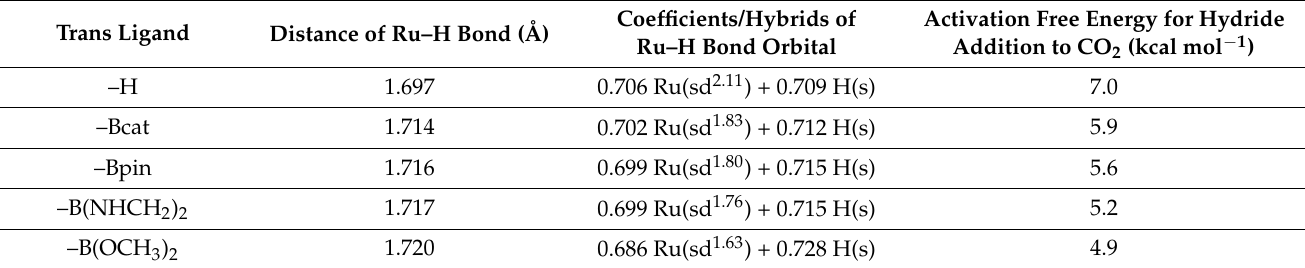
Figure 1. Free energy profile for the addition of hydride to CO 2 on the Ru PNP-type complex with different trans ligands. The substituent on phosphorus is omitted for clarity. Table 2. Bond distance of the Ru–H bond, bonding parameter of the Ru–H bond, and activation free energy for hydride addition to CO 2 on the Ru PNP-type complex with different trans ligands.